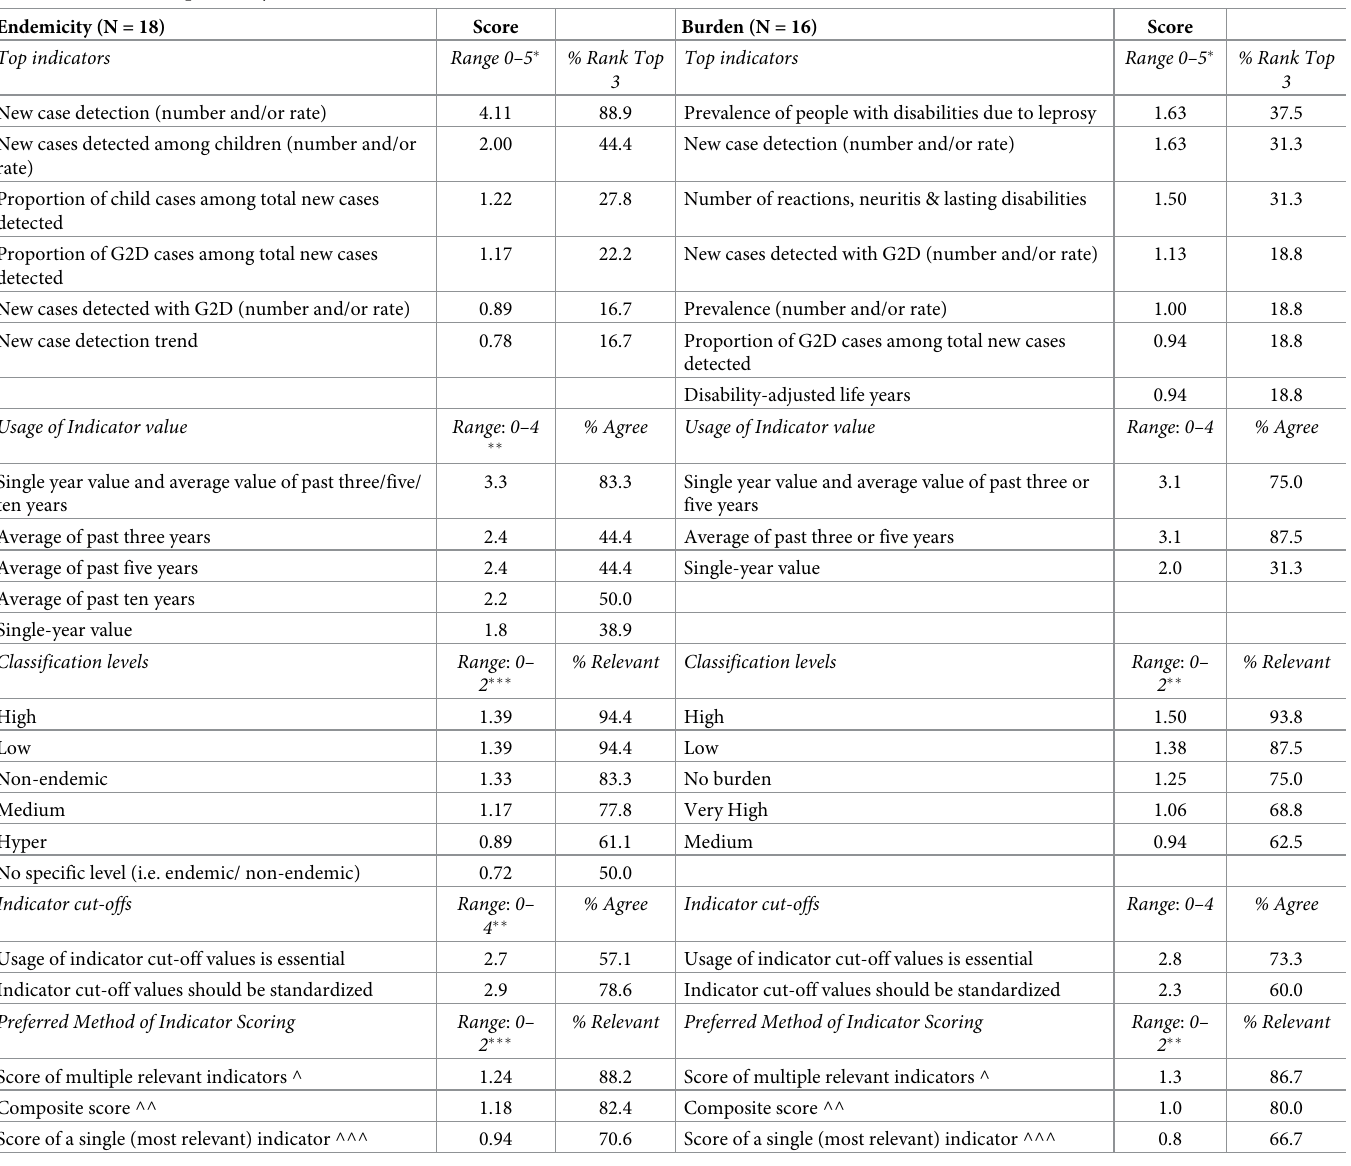
Table 3. Results of Delphi